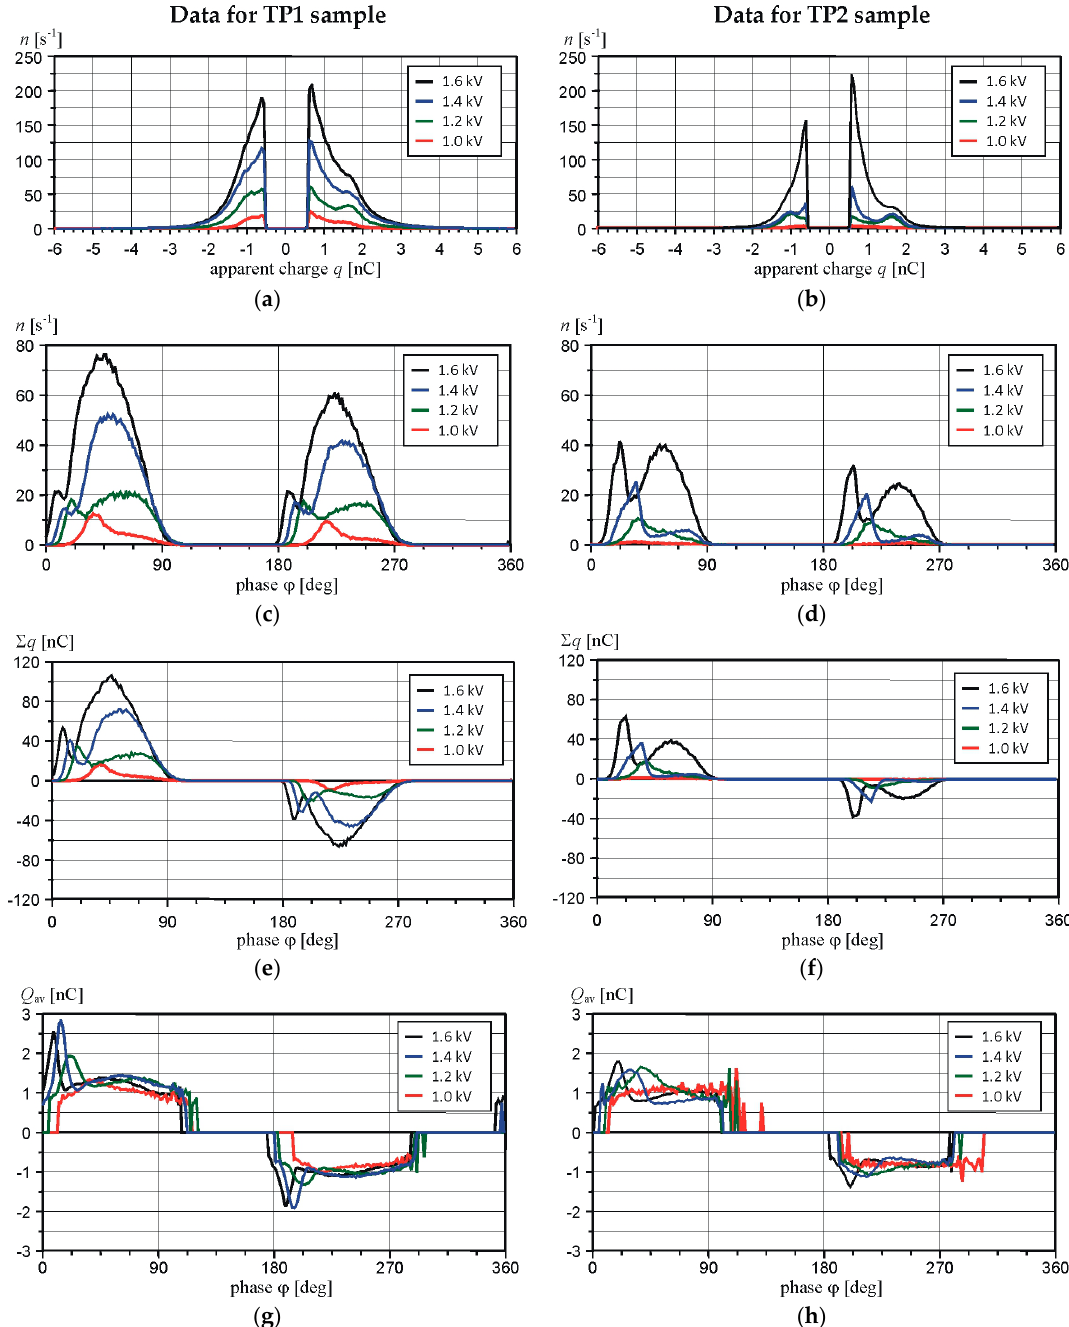
Figure 23. Evaluated amplitude and phase distributions of PD data for TP1 and TP2 samples: ( a ) and ( b ) number of PD pulses vs. apparent charge n ( q ); ( c ) and ( d ) phase distribution of the number of PD pulses n ( ϕ ); ( e ) and ( f ) phase distribution of the total charge Σ q ( ϕ ); ( g ) and ( h ) phase distribution of the average charge Q av ( ϕ ). All data normalized per